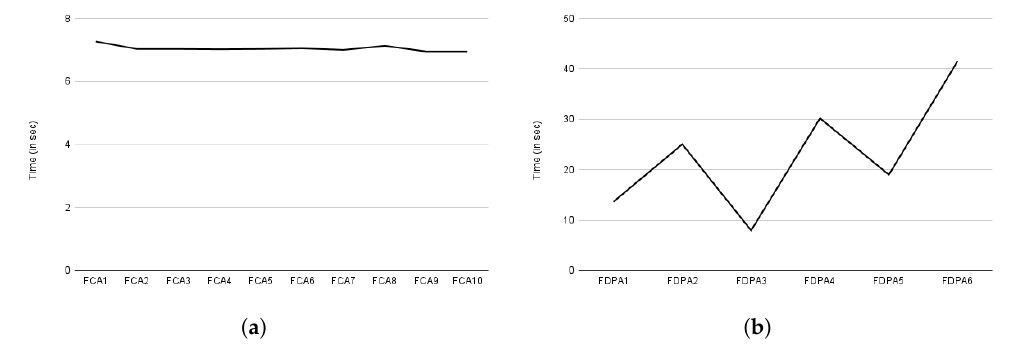
Figure 18. Time spent on auditing. ( a ) Execution time for full audit based on consent. ( b ) Execution time for full audit based on data